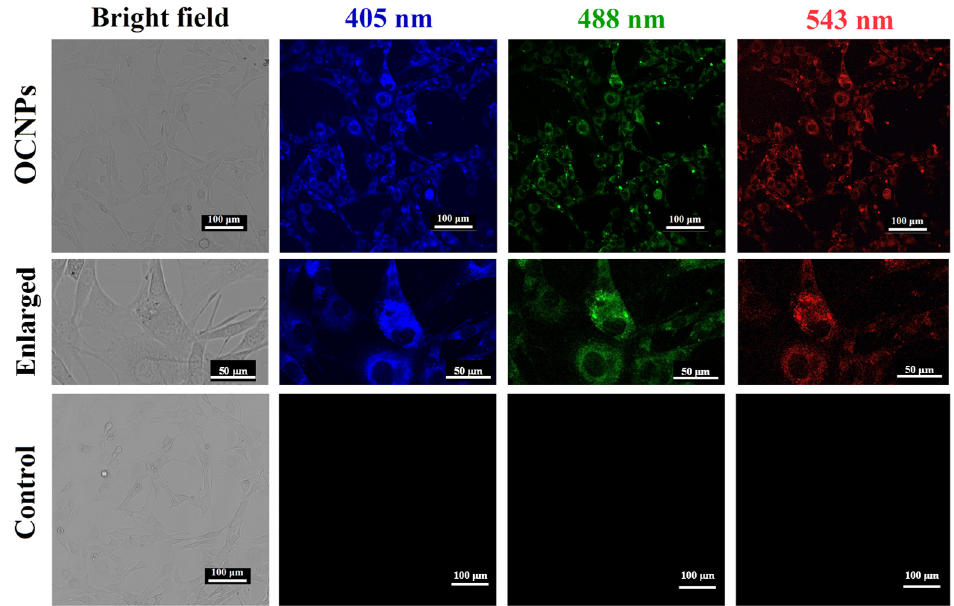
Figure 2. Images of bright field and fluorescence images of MC3T3-E1 cells incubated with OCNPs from grilled turbot.